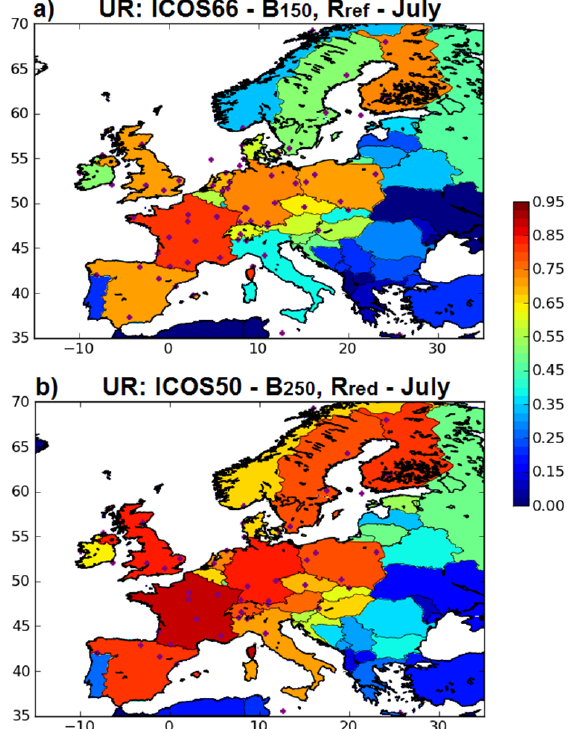
Figure 11. Uncertainty reduction (theoretically comprised between 0 and 1) for a 2-week-mean NEE at the country scale in July when modifying the inversion configuration from the reference one by us- ing B 150 instead of B 250 and ICOS66 (a) using R red instead of R ref and ICOS50 (b) . Red/blue colors indicate relatively high/low uncer- tainty reduction (with min = 0 and max = 0.95 in the color